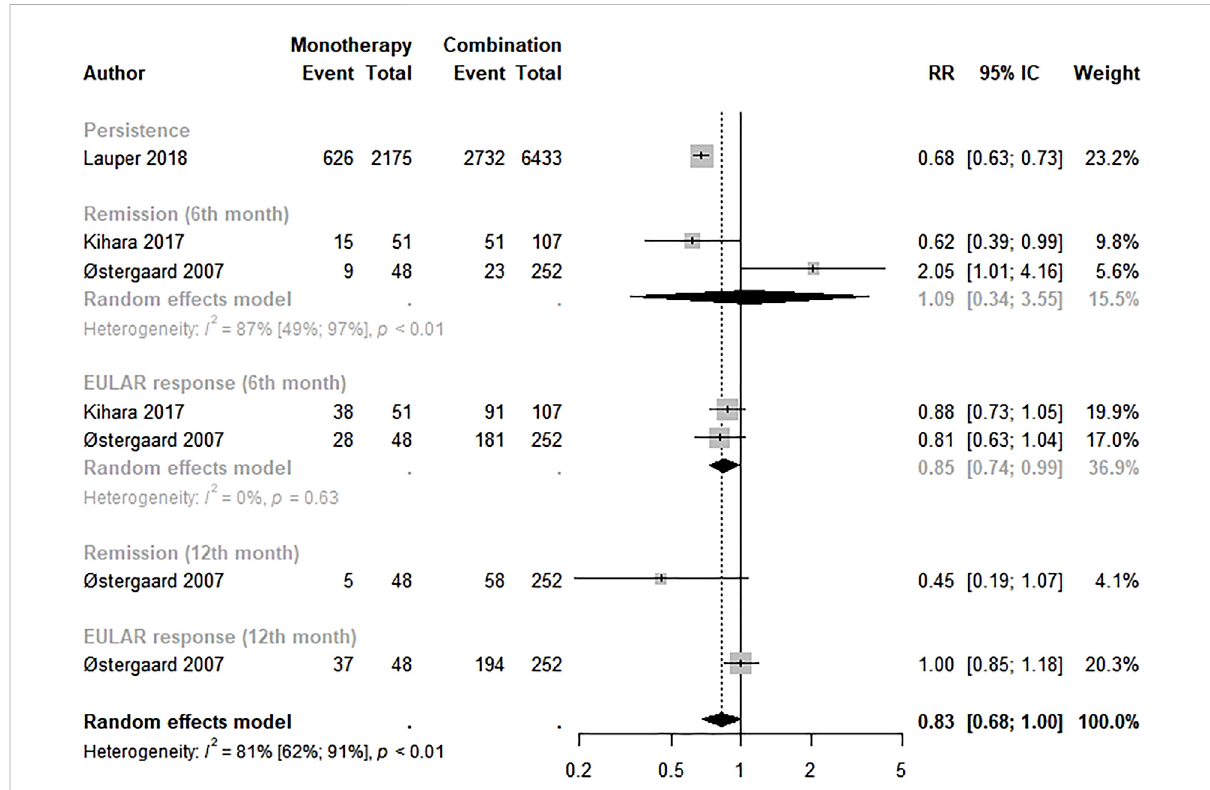
FIGURE 5 Effectiveness of biological disease-modifying anti-rheumatic drugs monotherapy compared to combination therapy. Monotherapy: biological disease-modifying anti-rheumatic drugs monotherapy; combination: biological disease-modifying anti-rheumatic drugs +